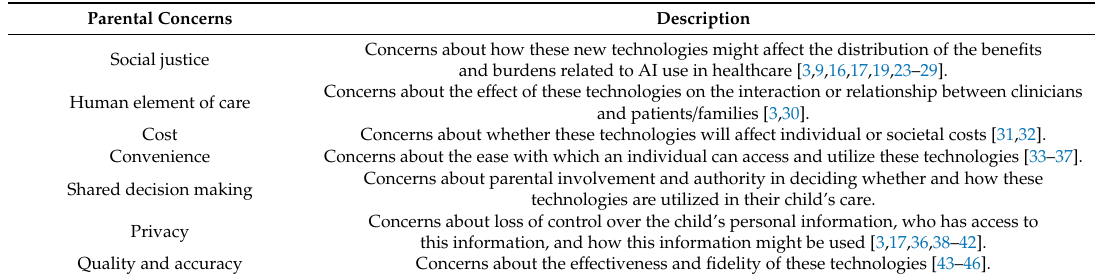
Table 1. Parental concerns with AI-driven healthcare